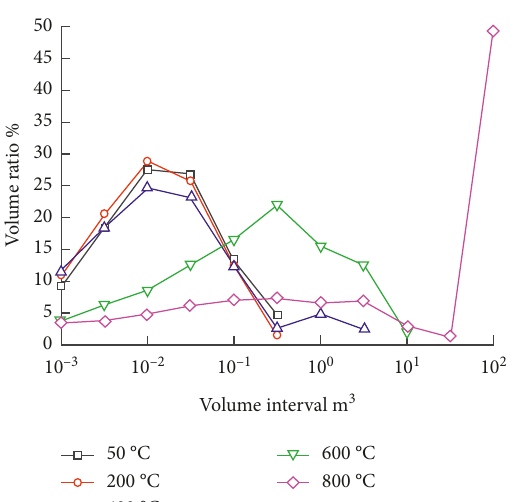
Figure 9: Proportion of microstructures in each volume interval of granite.